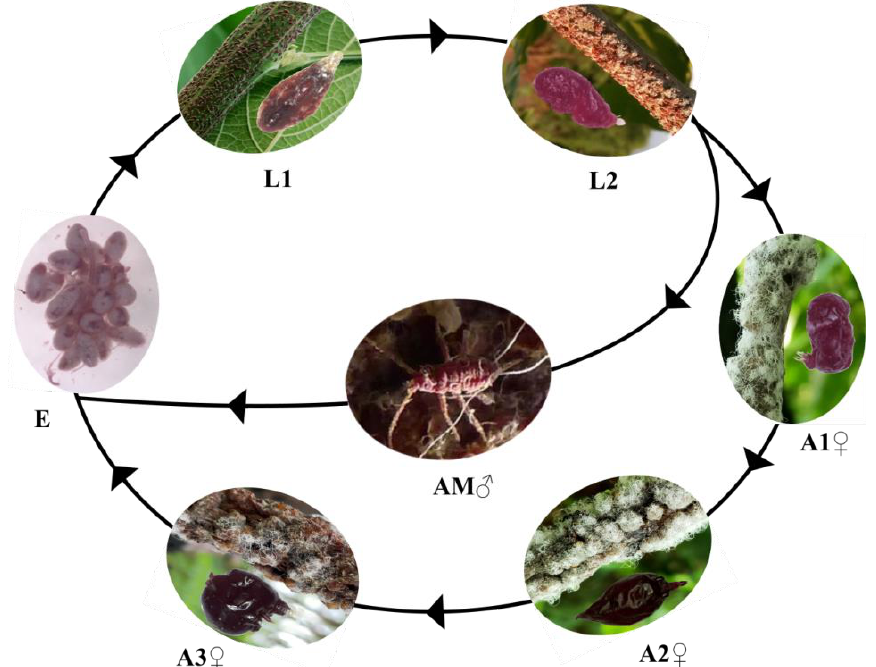
Figure 1. Life cycle of lac insects: females and males are morphologically different to each other. Showing eggs (E), early instar larvae (L1), late instar larvae (L2), early adult (A1), mid adult (A2), late adult (A3), and adult male (AM).